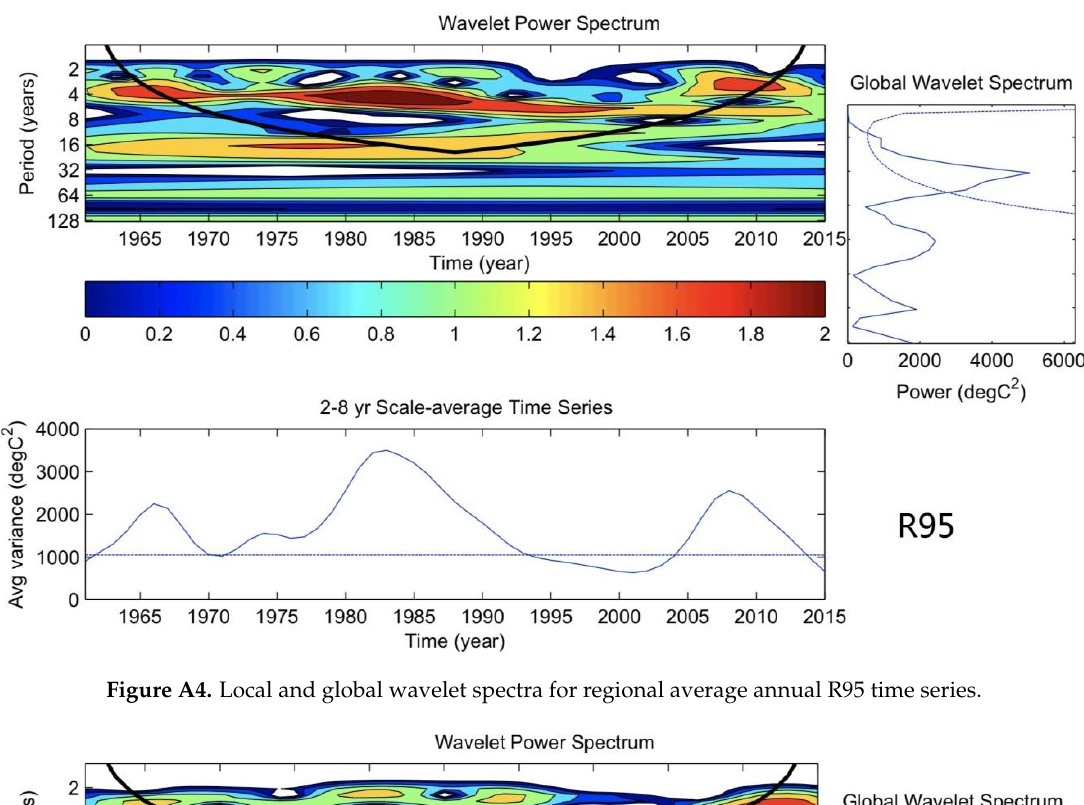
Figure A4. Local and global wavelet spectra for regional average annual R95 time series.